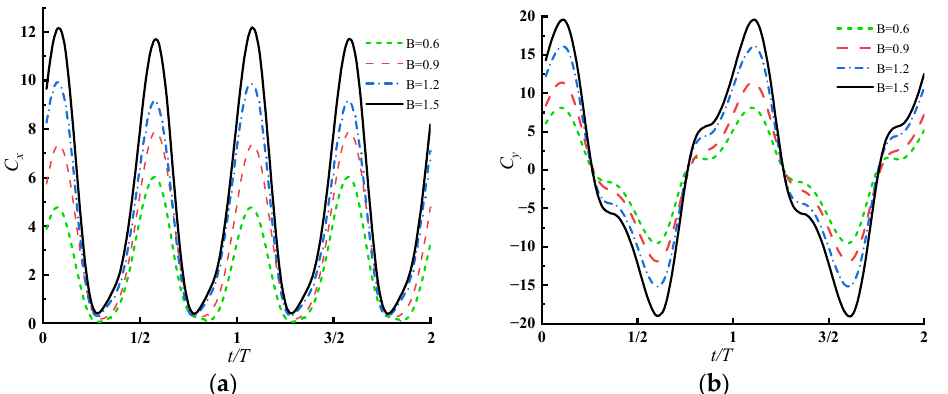
Figure 8. Variation of instantaneous thrust and lift coefficients with different passage width: ( a ) Instantaneous thrust coefficients; ( b ) Instantaneous lift coefficients.